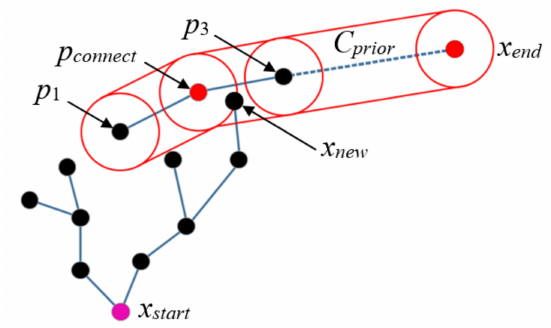
Figure 8. Selection of the prior connection node.